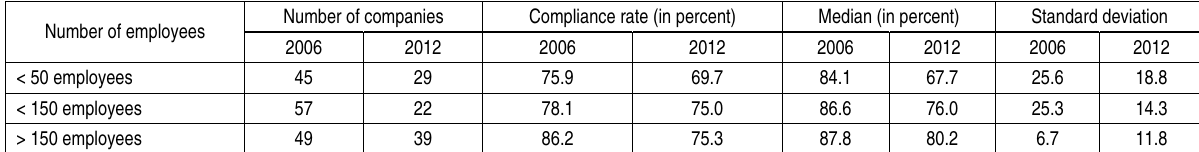
Table 2. Code compliance according to firm size (number of employees)